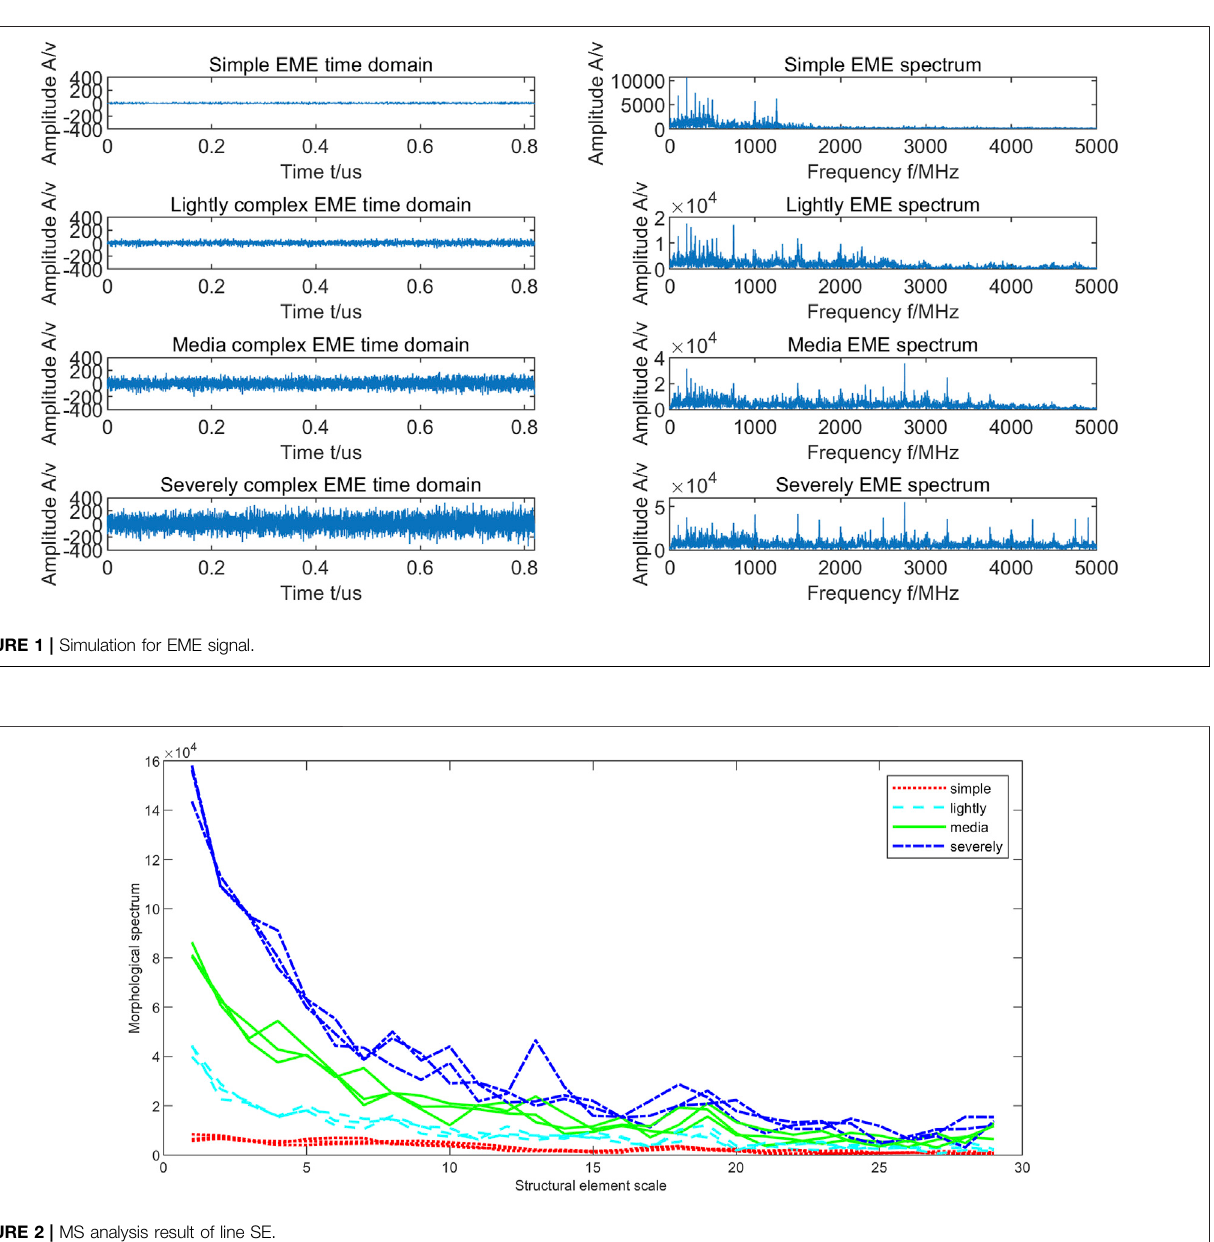
FIGURE 2 | MS analysis result of line